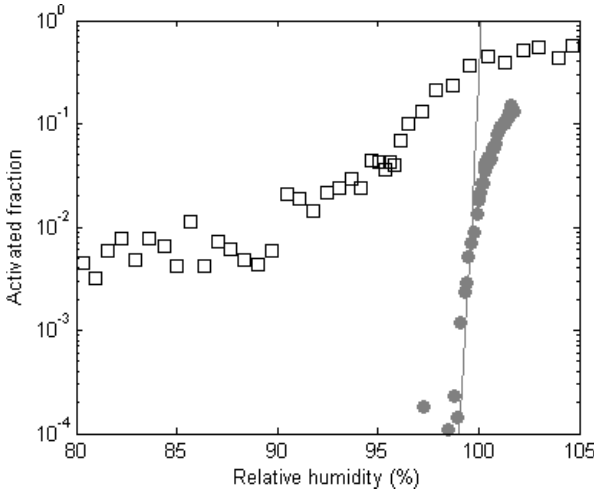
Fig. 6. Freezing activation curves of dry generated 200nm CID (open squares) and 200nm ammonium sulfate (filled grey symbols) at − 40 ◦ C. The solid grey line is the homogeneous freezing activa- tion curve of perfectly monodisperse ammonium sulfate predicted using the Koop et al. (2000)